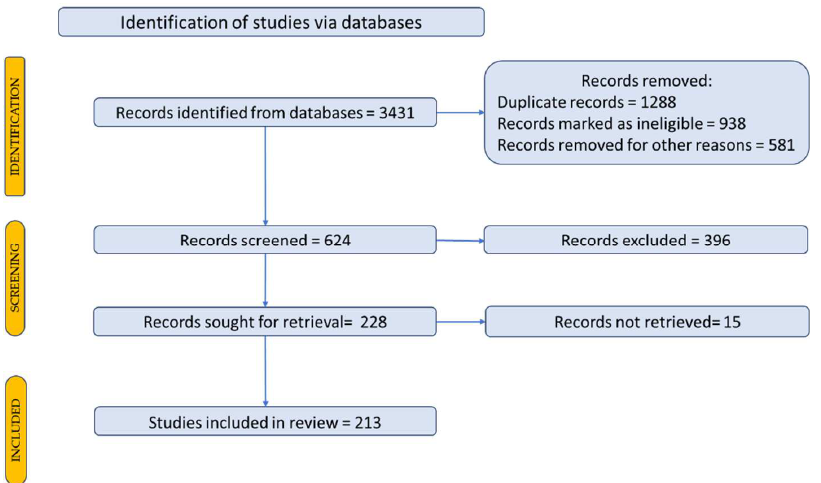
Figure 3. Prisma flow diagram for a description of the selection process of the bibliographic sources.